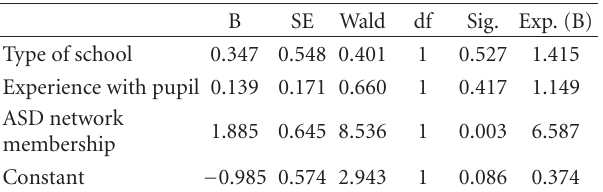
Table 3: Direct logistic regression on attitude towards teaching pupils with